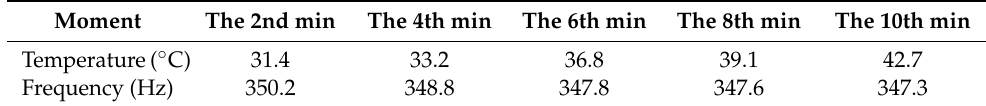
Table 3. Vibration frequency data of the gear system at different temperatures